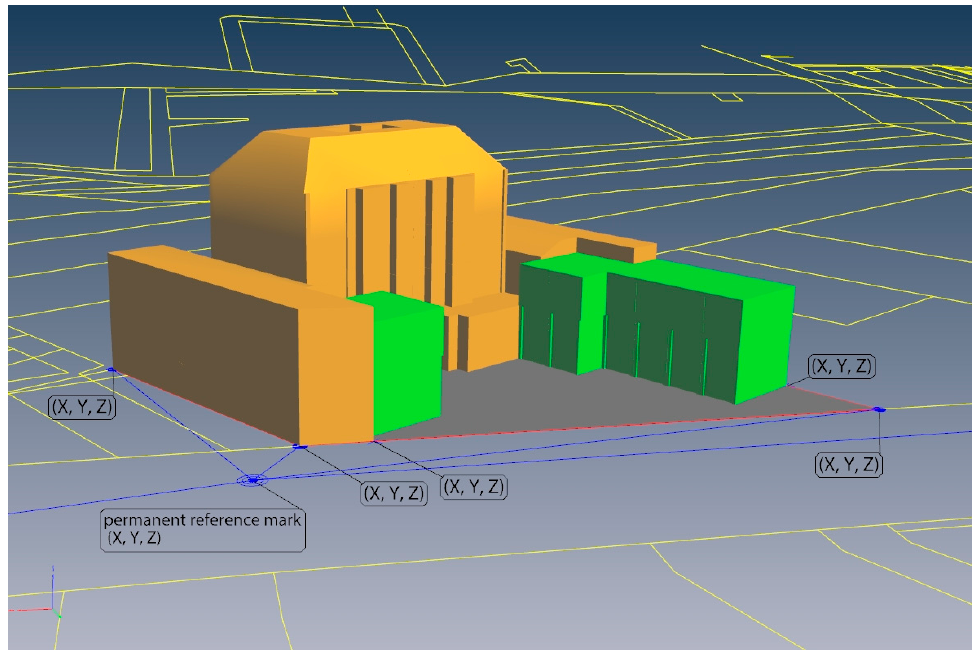
Figure 11. 3D parcels coordinated in terms of the underlying parcel and permanent reference mark.